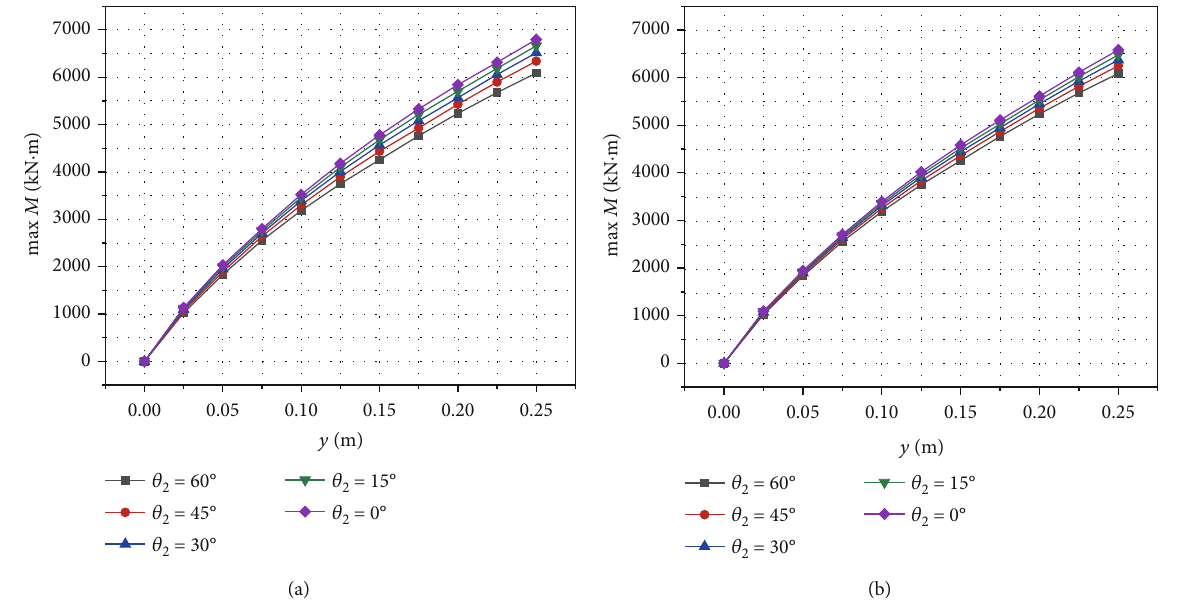
Figure 18: E ff ect of θ